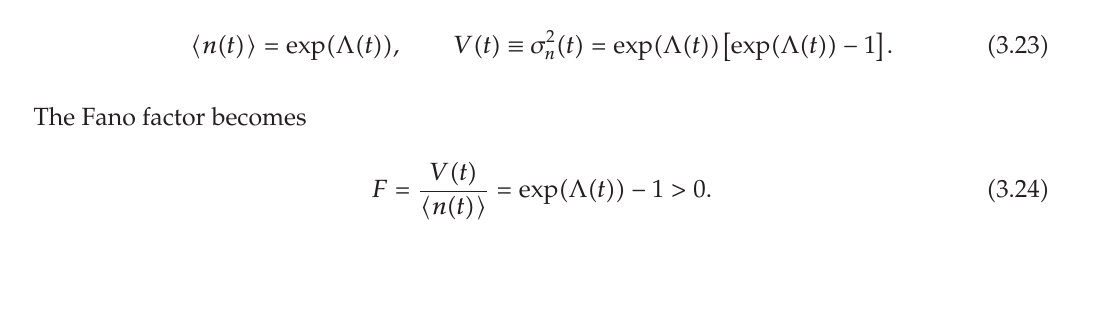
The corresponding probability density p (cid:3) n, t (cid:4) is obtained